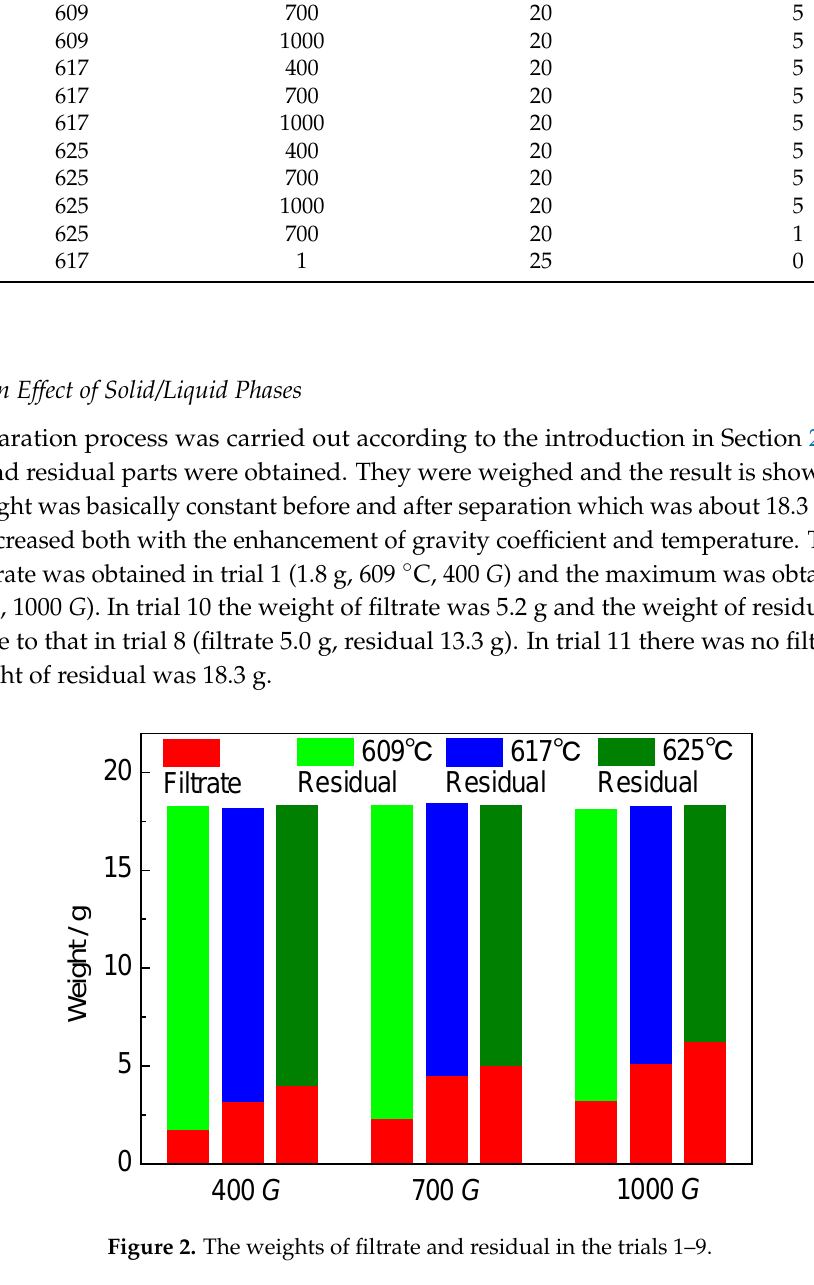
Table 2. Experimental conditions used in this study.